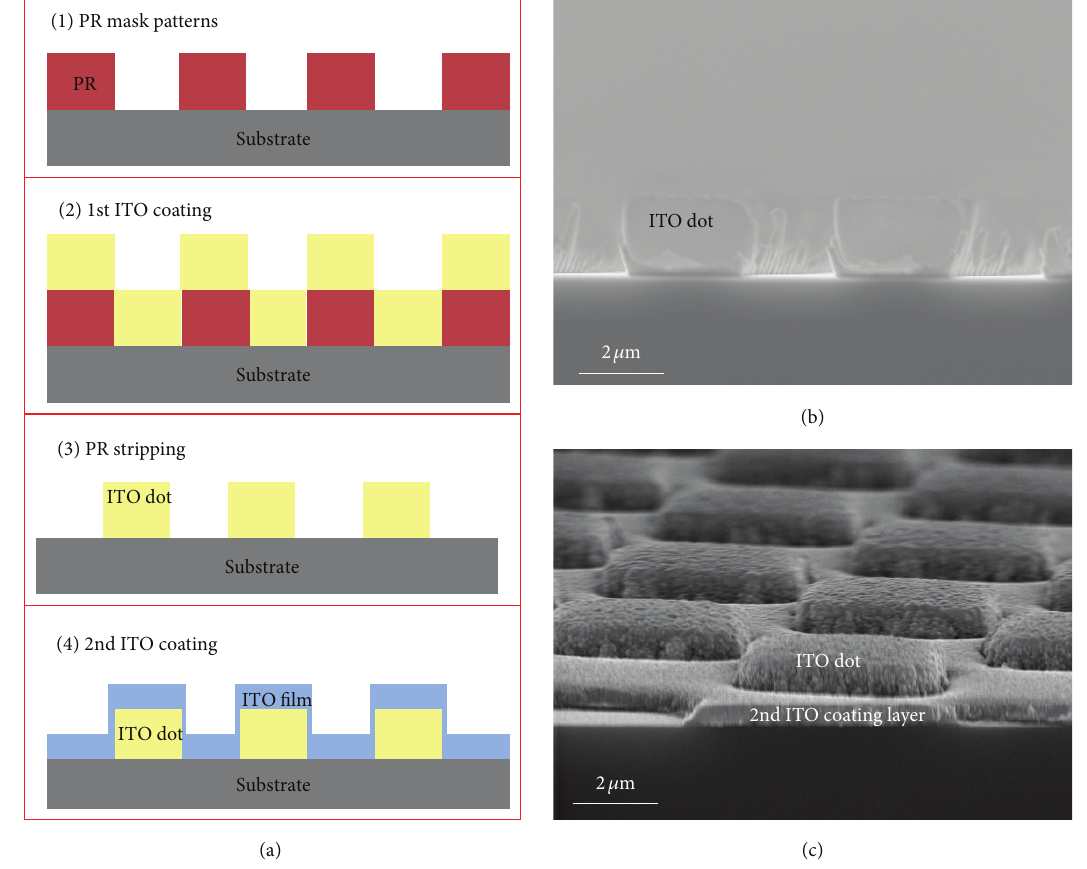
Figure 1: (a) Step-by-step procedure of preparing 3D ITO dots; (b) SEM image of 3D ITO dot after PR stripping; (c) SEM image of 3D ITO dot covered with second ITO layer that connects all dots